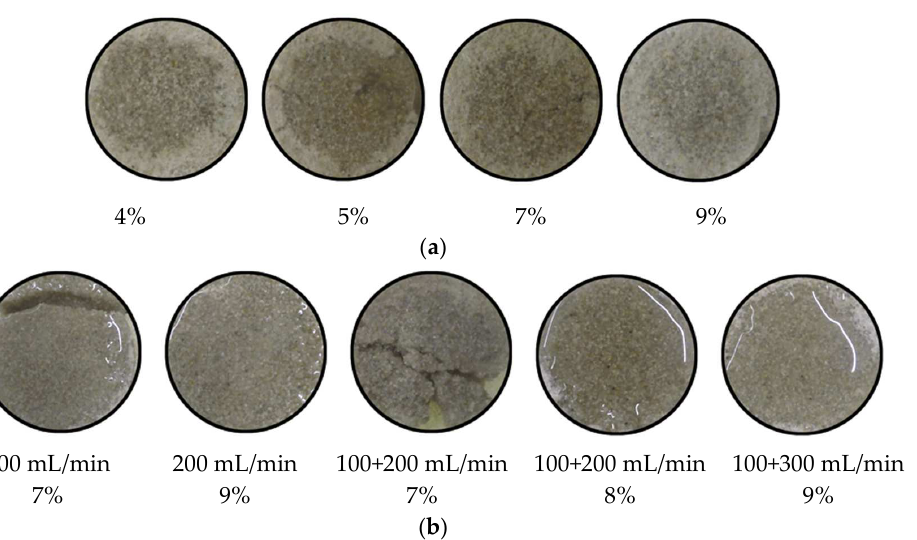
Figure 7. Snapshots of the fractures immediately after the failure appeared during glycerine injection experiments at ( a ) 30 mL/min with cementation level increasing from left to right and ( b ) for various combinations of flow rates in coarse bio-cemented sands across various cementation levels. The pressure profiles obtained for relatively low, moderate, and heavily cemented samples are depicted in Figure 8a for flow rates of 30 mL/min. A clear pressure peak was observed in the sample with a cementation level of 7% (270 kPa), which then reduced to about 200 kPa. The specimens with a cementation level of 5% and 7% were damaged to a greater degree compared to the specimen of lower strength. Even stronger medium grain cemented sands (cementation level of 9%) did not experience a fracture, as the pressuri- sation rate (i.e., increase of pressure over time) was not enough to induce a fracture since these specimens were stronger. The propagation pressures shown in the figure are analo- gous to the strength of the specimens and hence to the cementation level.